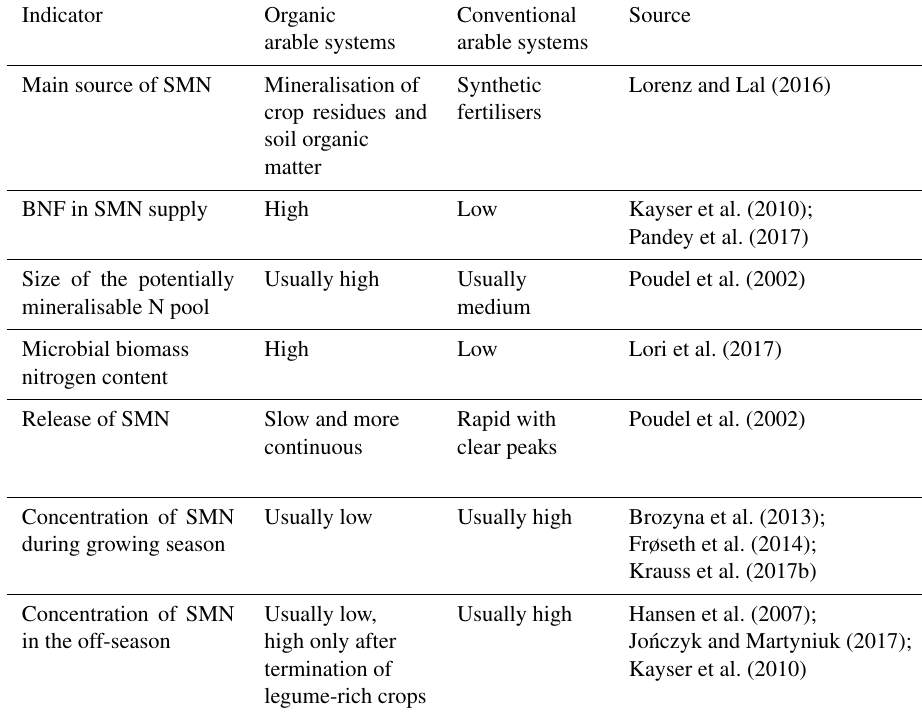
Table 1. Performance of selected drivers of SMN in organic and non-organic cropping systems. Indicator Organic Main source of SMN Mineralisation of BNF in SMN supply High Low Kayser et al. (2010); Size of the potentially mineralisable N pool Microbial biomass nitrogen content Release of SMN Slow and more Concentration of SMN during growing season Concentration of SMN in the off-season